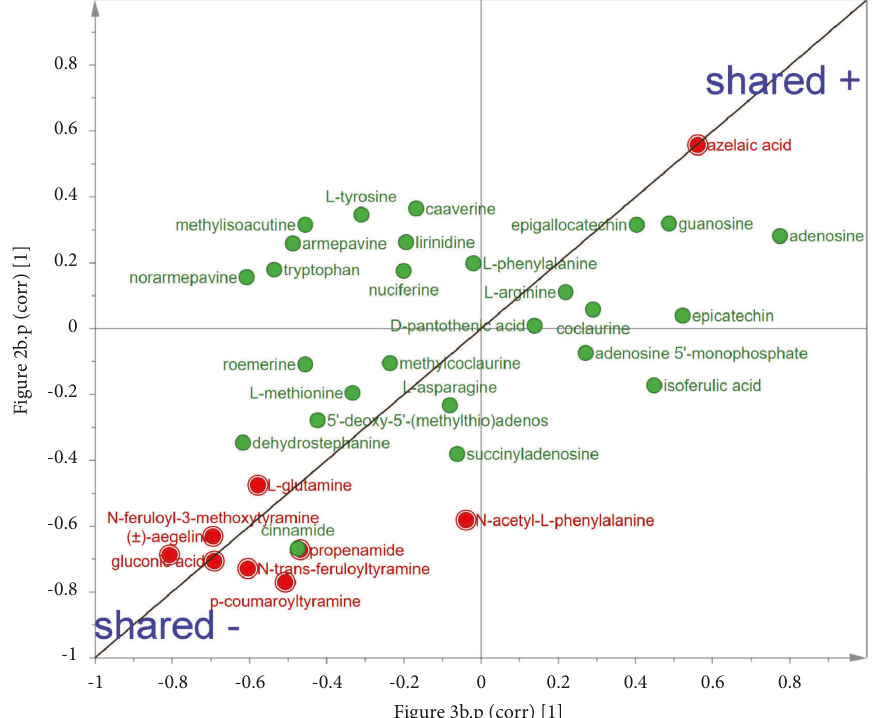
Figure 3b.p (corr) [1] Figure 4: SUS-plot of two OPLS models (browning and ecotype